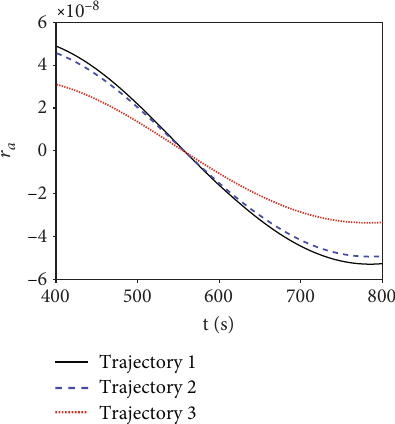
Figure 2: Variation of r